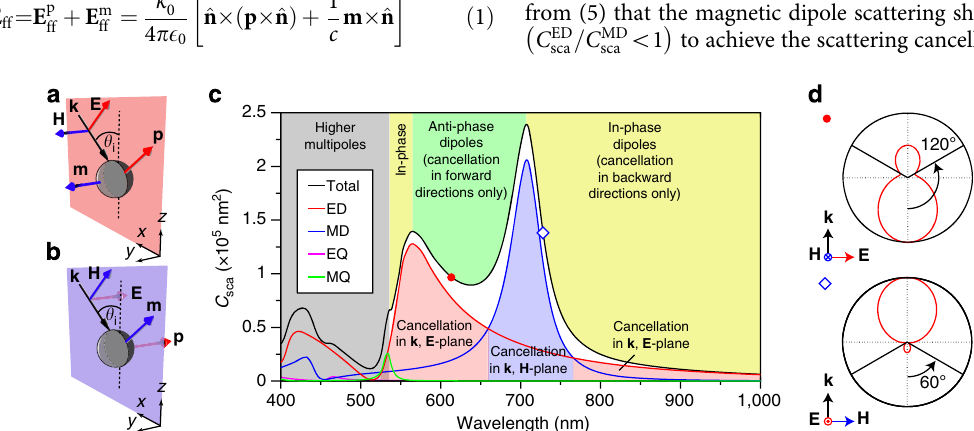
Figure 2 | Optical properties of a silicon spheres in air under plane wave illumination. ( a , b ) Schematic representation of the two situations studied. ( c ) Total scattering cross section (black curve) and contributions from the electric dipole (red curve), magnetic dipole (blue curve), electric quadrupole (magenta curve) and magnetic quadrupole (green curve) from a silicon sphere with diameter D ¼ 180nm. The different shaded regions indicate those wavelength windows for which the induced electric and magnetic dipoles are approximately in phase (yellow) or in anti-phase (green), and those for which the electric dipole (light red) or the magnetic dipole (light blue) dominate over the other. ( d ) Far-field radiation patterns for two wavelengths leading to inhibition of radiation at 60 (cid:2) with respect to the forward- ( l 1 ¼ 614nm, red solid circle) and backward- ( l 2 ¼ 728nm, blue hollow diamond) scattering directions. In the first case zero radiation is only possible in the plane parallel to the electric field whereas in the second it is only possible in the perpendicular